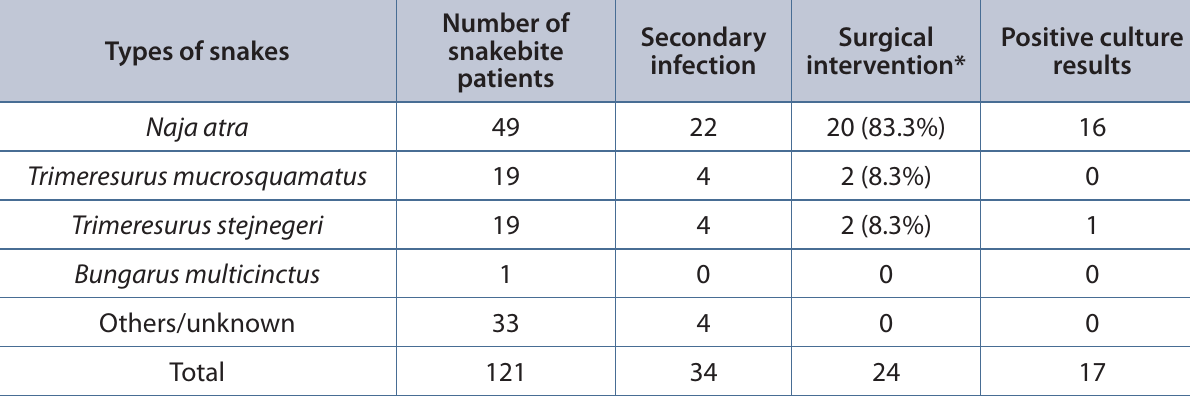
Table 1. Snake species and secondary infection following snakebite in central Taiwan Types of snakes